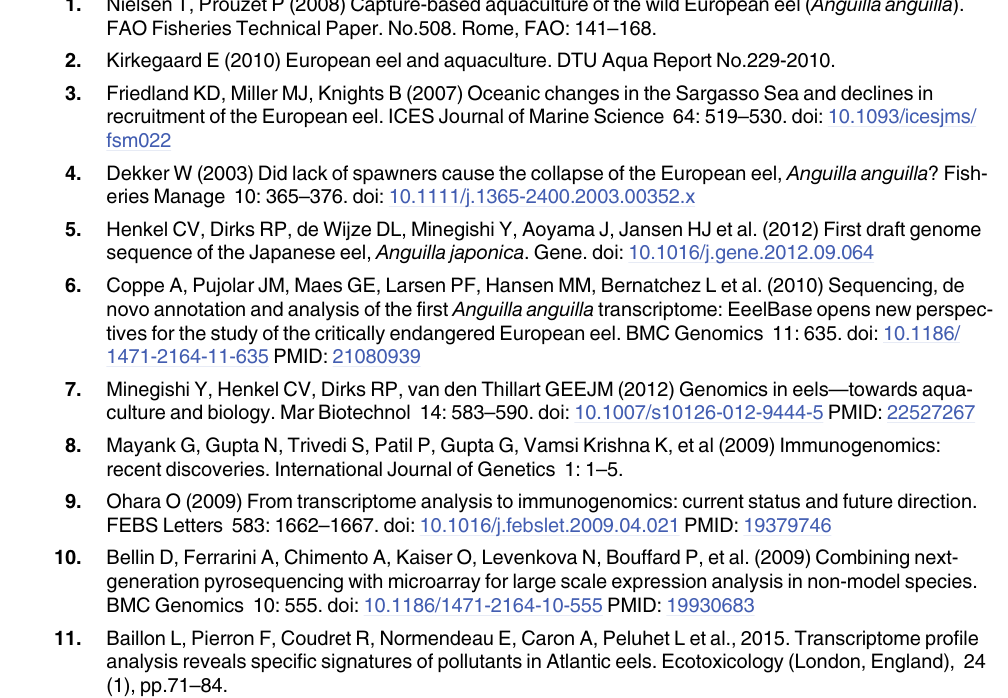
S2 File. Table A Classification of DEGs by loop analysis after 0, 3 and 12h after R99 or CT285 bath infection. One-way ANOVA followed Tukey ’ s test with significance value of p < 0.05 and no FC cut-off. Table B: Classification of DEGs by relative analysis against handling control group after 0, 3 and 12h after R99 or CT285 bath infection. One-way ANOVA followed Tukey ’ s test with significance value of p < 0.05 and no FC cut-off. Fig A: Venn diagram showing common transcripts differentially expressed along the infection with R99 analyzed by relative analysis approach. Fig B. Venn diagram showing common transcripts differentially expressed along the infection with CT285 analyzed by relative analysis